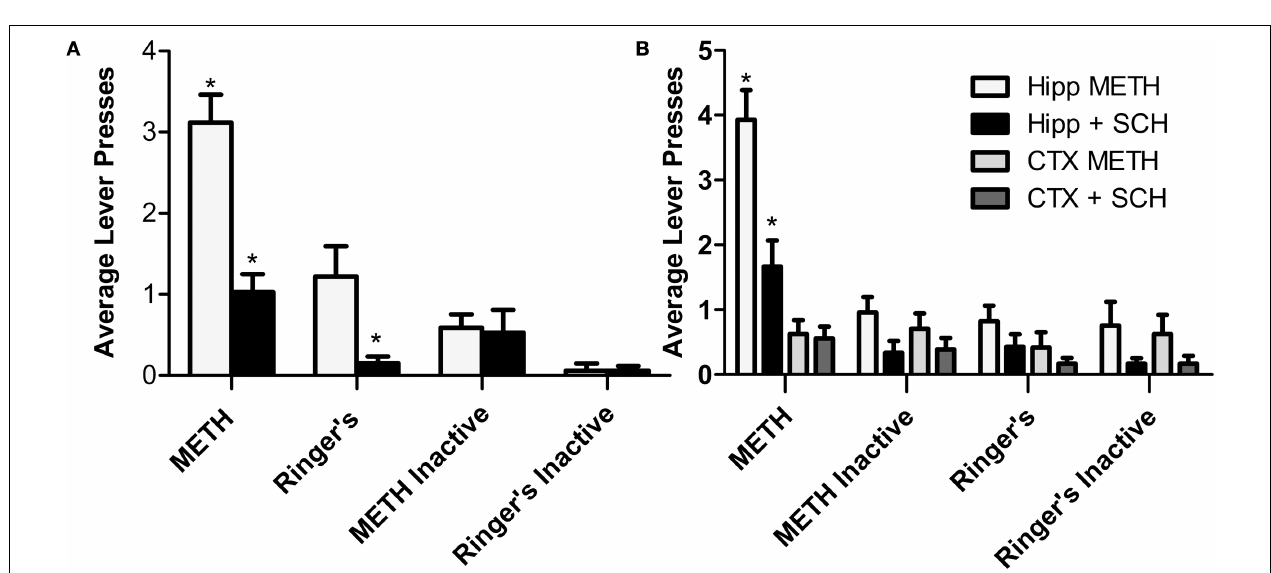
induces lever-pressing in the hippocampus and not the cortex (CTX). All groups were co-treated with 100 µM SCH 23390 during days 5–7. Intrahippocampal METH group active lever presses were signifi cantly greater than CTX METH and Ringer’s vehicle groups from day 2 onward. The symbol * represents a difference from all other groups ( P < 0.05). Hippocampus METH group: upside-down black triangles; Hippocampus METH inactive: light gray diamonds; Hippocampus Ringer’s: dark gray triangles; CTX METH: black fi lled circles.